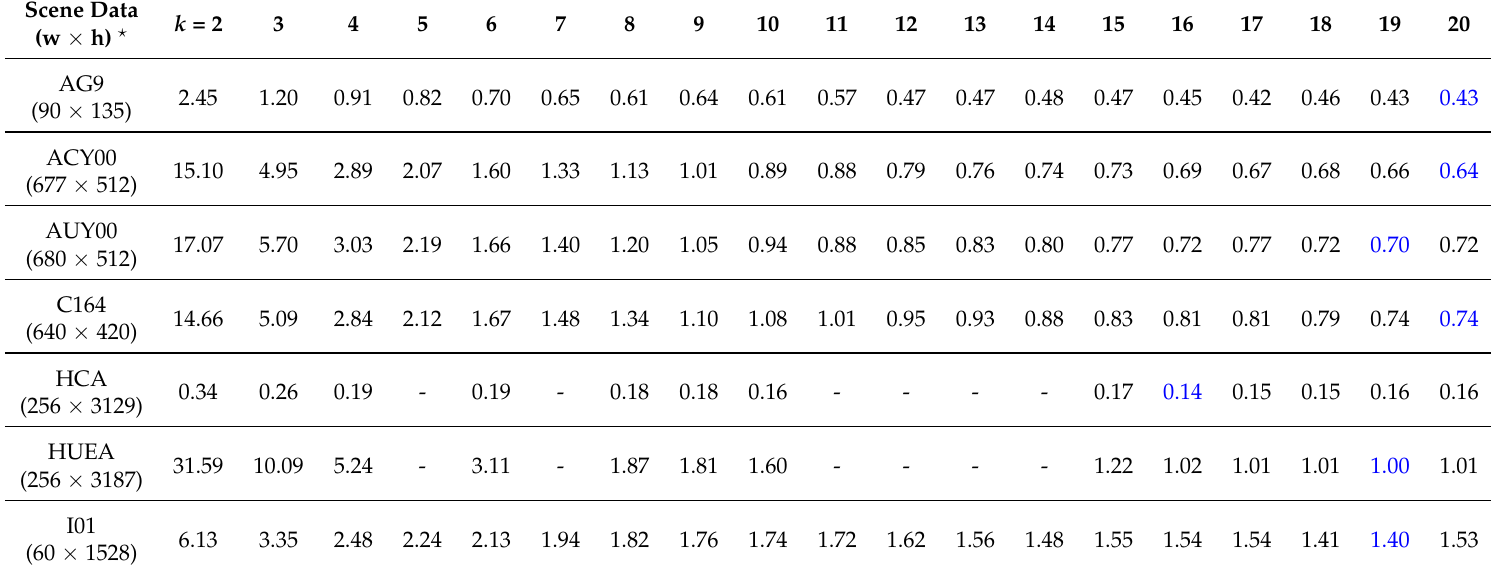
Table 10. Access time ( µ s) for a random cell query with different kvalues. Each result is the average time over 100,000 consecutive queries. The best results are highlighted in